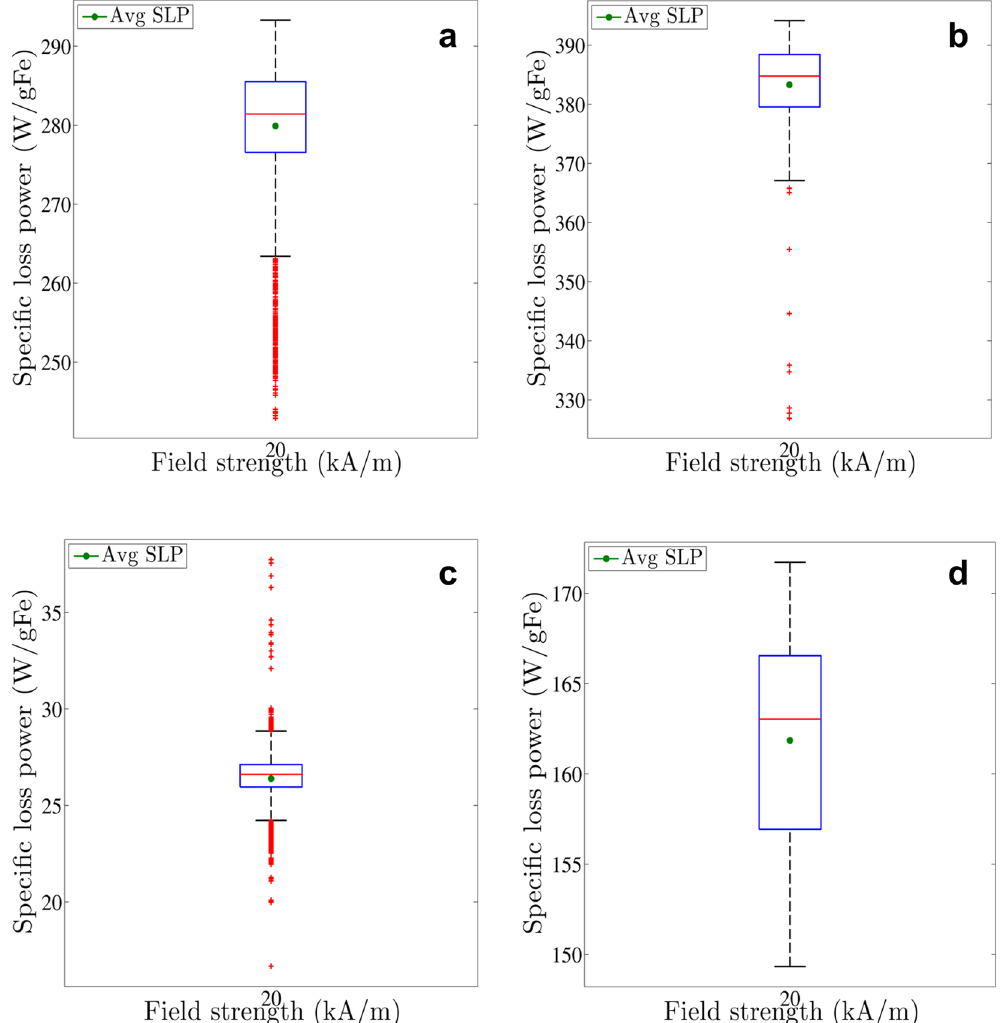
Figure 2. Box-and-whisker plot of all possible SLP values that meet the (quasi-)adiabatic criterion in the case of BNF-Dextran ( a ), JHU ( b ), nanomag ® -D-spio ( c ) and MnFe 2 O 4 ( d ) nanoparticles measured at 150 kHz and 20 kA/m. The (green) dot within the box always denotes the mean of all SLP values corresponding with (quasi)- adiabatic heating. The blue lower and upper box boundaries are always the first and third quartiles (SLP 25% & SLP 75% ), whereas the median (SLP 50% ) is depicted by the red horizontal line. The difference between the end of the whiskers (adjacent values) and the box boundaries can maximally be 1.5 times the interquartile distance, i.e. SLP 75% - SLP 25% . The red crosses represent each calculated SLP value lying outside the range between the whisker ends, i.e.